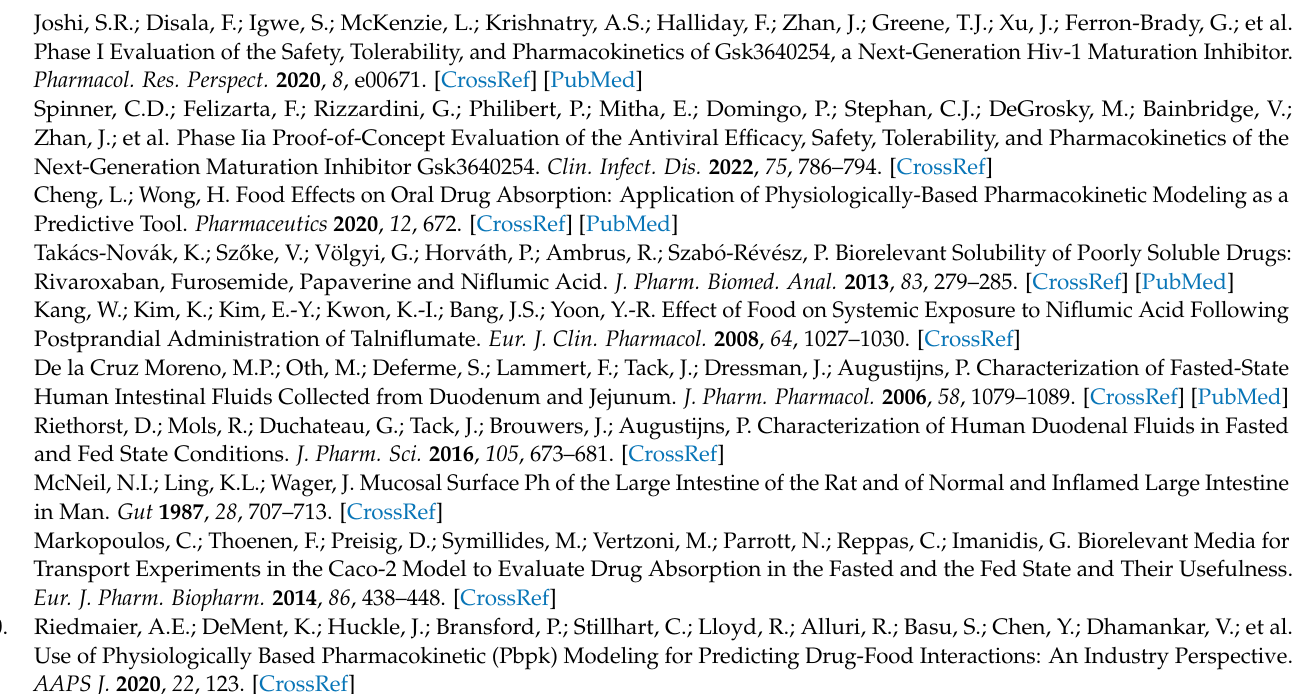
Figure S5: Comparison of model predictions against clinical data (ADME study) using deconvoluted dissolution profile (A): LogK M:W estimated from FaSSIF/FeSSIF media; (B): LogK M:W estimated from FaSSIF +OA+CH /FeSSIF +OA+CH media) and Dissolution Layer Model (DLM) (C): LogK M:W estimated from FaSSIF/FeSSIF media; (D): LogK M:W estimated from FaSSIF +OA+CH /FeSSIF +OA+CH media); Figure S6: Comparison of moderate- and high-fat (FDA) meals (200 mg:2 × 100 mg tablets) on the bioaccessibility of GSK254 using